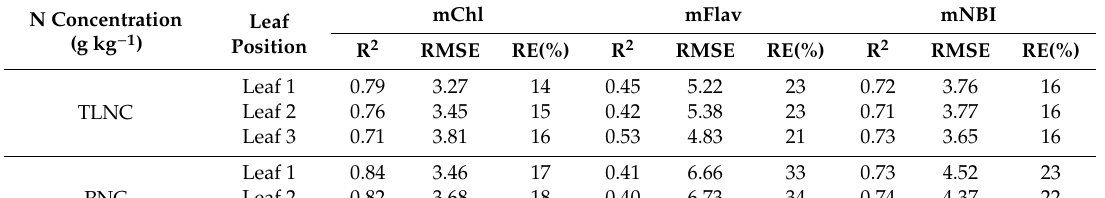
Table 5. Validation results for the estimation of TLNC and PNC using modified Dualex 4 parameters for single-position leaves by the general estimation models across growth stages.